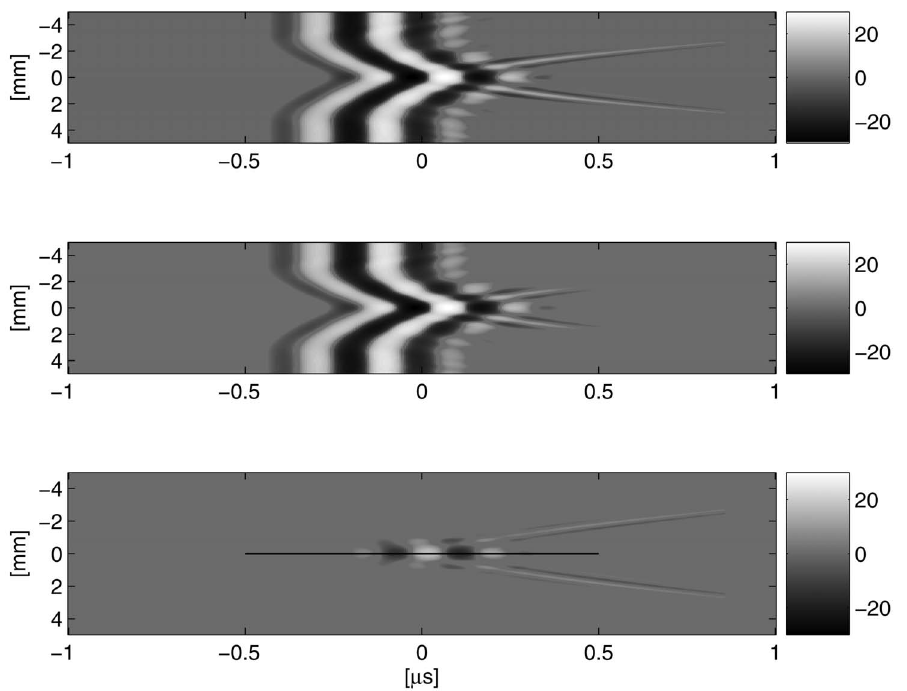
Figure 6. Comparison of the forward propagating wave fronts for the one-way wave equation using the parabolic approximation and the full wave equation. The wave fronts were recorded at a depth of 8.9 mm. Top: solution of the full wave equation. Middle: solution of the one-way wave equation. Bottom: difference between the two solutions. The line in the bottom picture indicates the location where the cross-section shown in Figure 8 is made. A (cid:6) 30 dB logarithmic grey scale is used in the